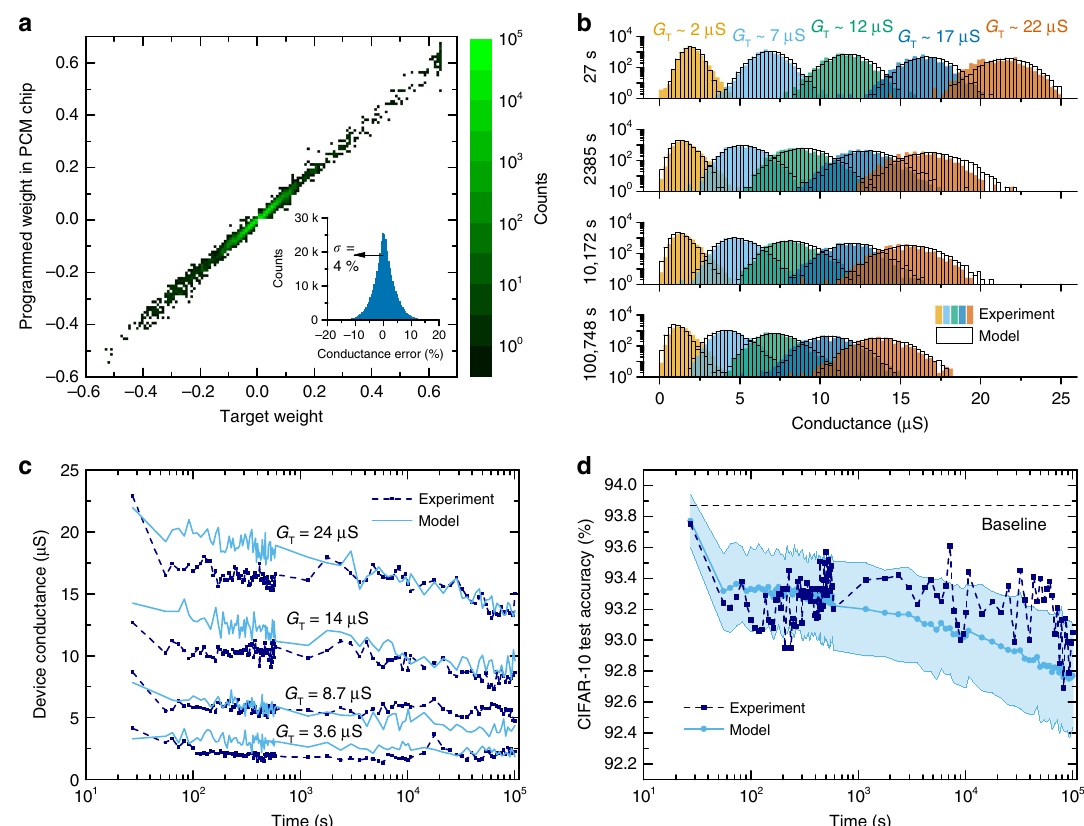
Fig. 4 Inference experiment with ResNet-32 on CIFAR-10. a Scatter plot of weights programmed in the PCM chip versus target weights obtained after training. The inset shows the distribution of the relative error between programmed and target synaptic conductance, ð G l ij (cid:2) G l deviation σ . b Distributions of programmed devices whose target conductance fall within 0.25 μ S from fi ve representative G T values. The distributions are shown at four different times spanning the experiment duration of one day. The fi lled bars are the measured hardware data, the black lines are the PCM model. c Individual device conductance evolution over time of four arbitrarily picked devices from the chip programmed to four distinct G T values, along with one PCM model realization for the same G T values. d Measured test accuracy over time from the weights of the PCM chip, along with the corresponding PCM model match. A global drift compensation (GDC) procedure is performed for every layer before performing inference on the test set. The fi lled areas from the PCM model correspond to one standard deviation over 25 inference runs. The baseline refers to the FP32 software accuracy of